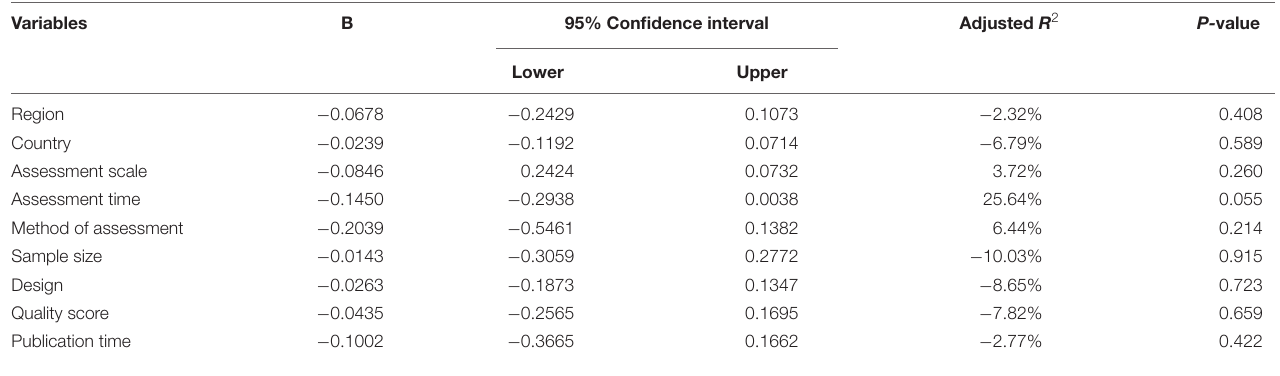
TABLE 3 | Meta-regression analyses of the effects of potential